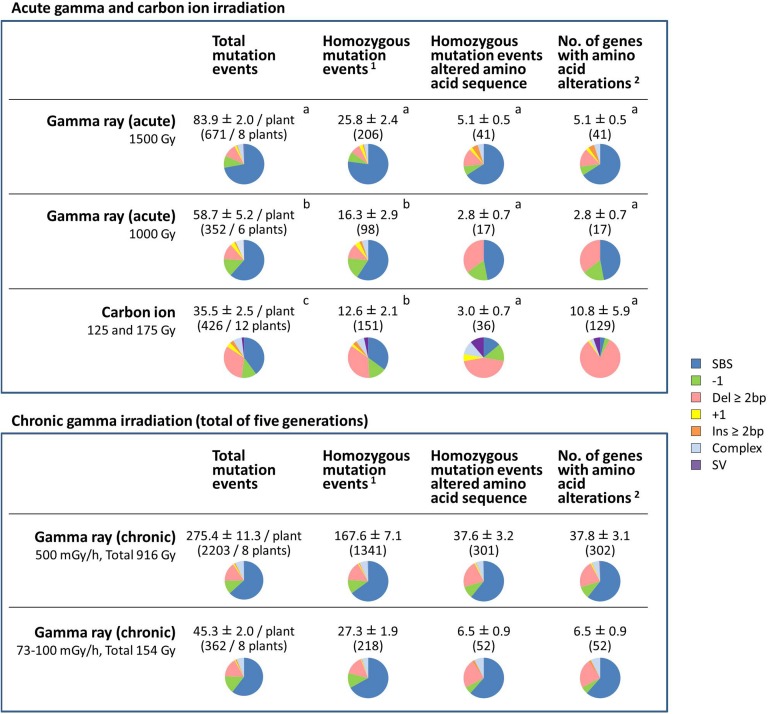
Comparative characterization of the effects of gamma ray- and carbon ion-induced mutation events on protein-coding genes. The values are means ± standard errors of mutation events per plant. The values in parenthesis are total numbers of mutation events. Pie charts represent the types of mutations. Data for carbon ions are from Hase et al. (2018). Different letters indicate significant differences among the acute irradiation treatments in each category (one-way ANOVA with multiple comparison test, p < 0.05). 1Structural variations including homozygous sequence alterations, which were confirmed by the Integrative Genomics Viewer (IGV), were counted. 2Transposable elements, pseudogenes and non-coding RNA were not included.